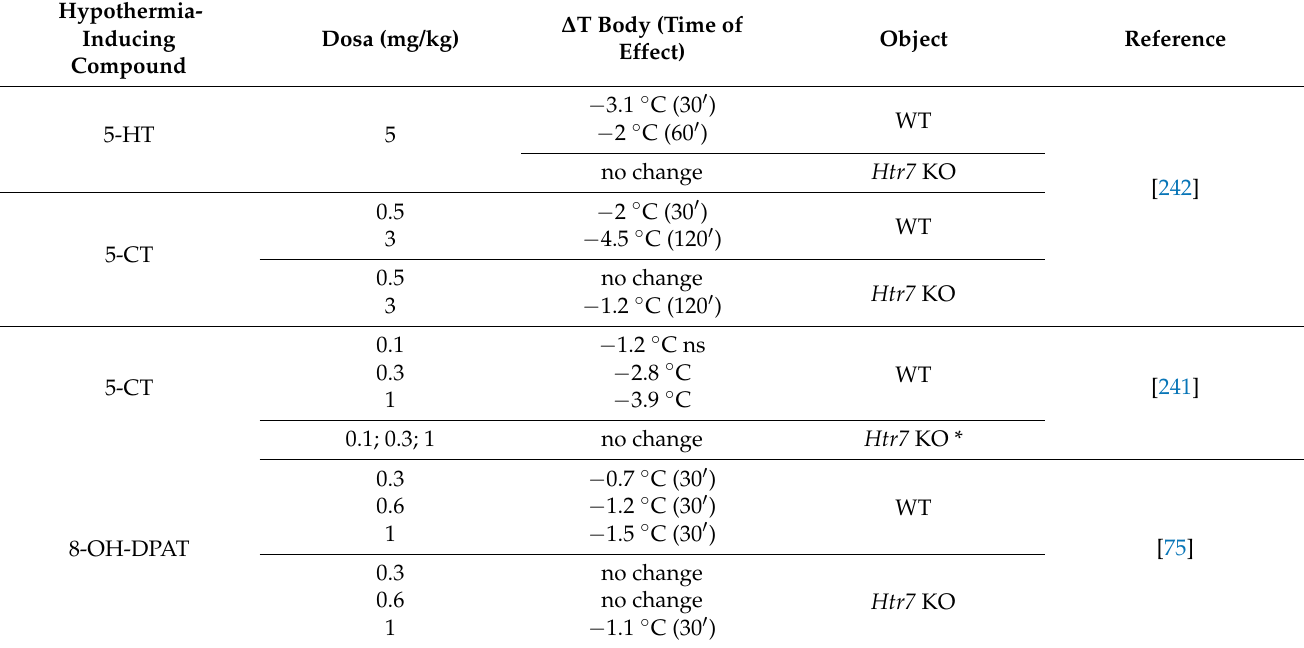
Table 8. Changes in body temperature of mice lacking the Htr7 gene ( Htr7 KO) and control (WT) ones after intraperitoneal injection of compounds inducing